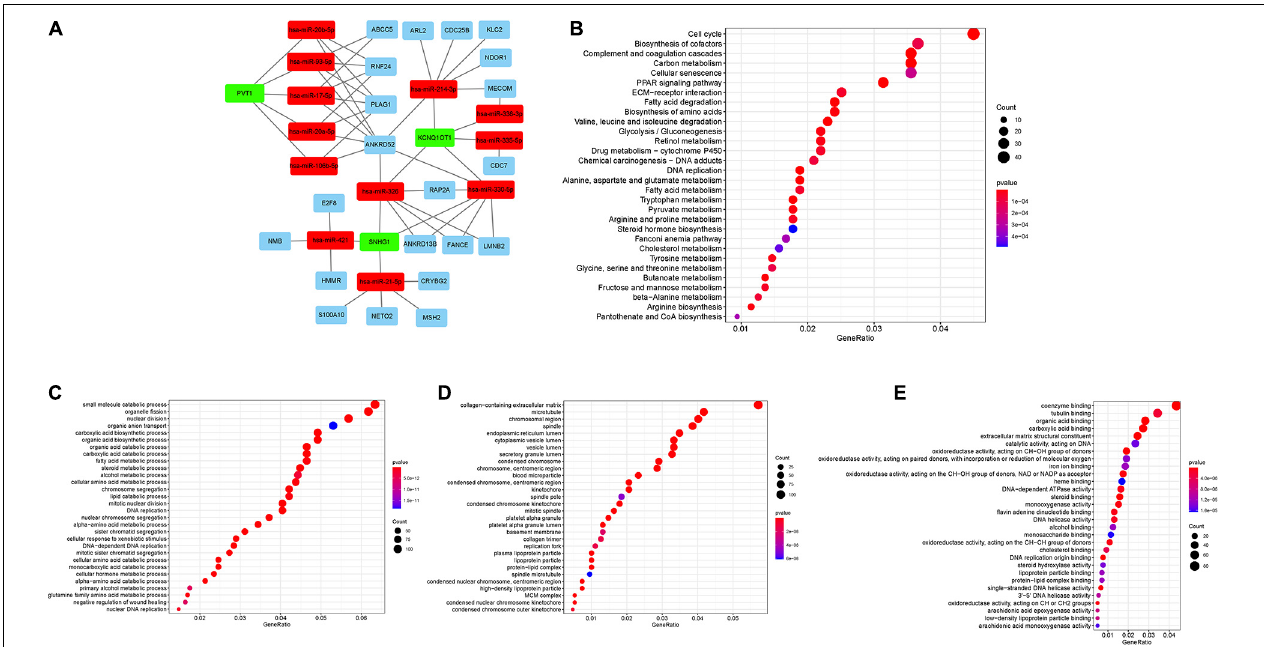
FIGURE 2 | (A) lncRNA–miRNA–mRNA ceRNA network in HCC. Green, red, and blue represent lncRNAs, miRNAs, and mRNAs, respectively. (B) KEGG enrichment analysis of DEMs. (C–E) GO enrichment analysis of DEMs: BPs, CCs, and